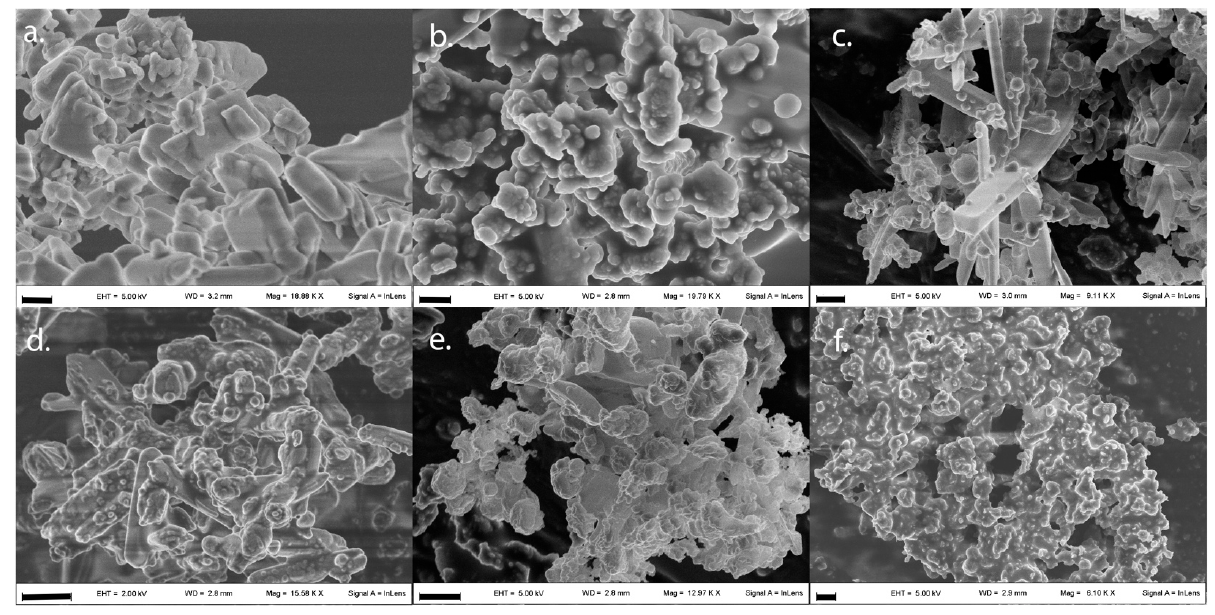
Figure 2. Morphological observation of samples produced at 95% of ASA loading. Pictures are representative of run# ( a ) 11, ( b ) 13, ( c ) 14, ( d ) 18, ( e ) 19, and ( f ) 20 of the experimental design in Table 2. Dimensional bars correspond to 2 µm.